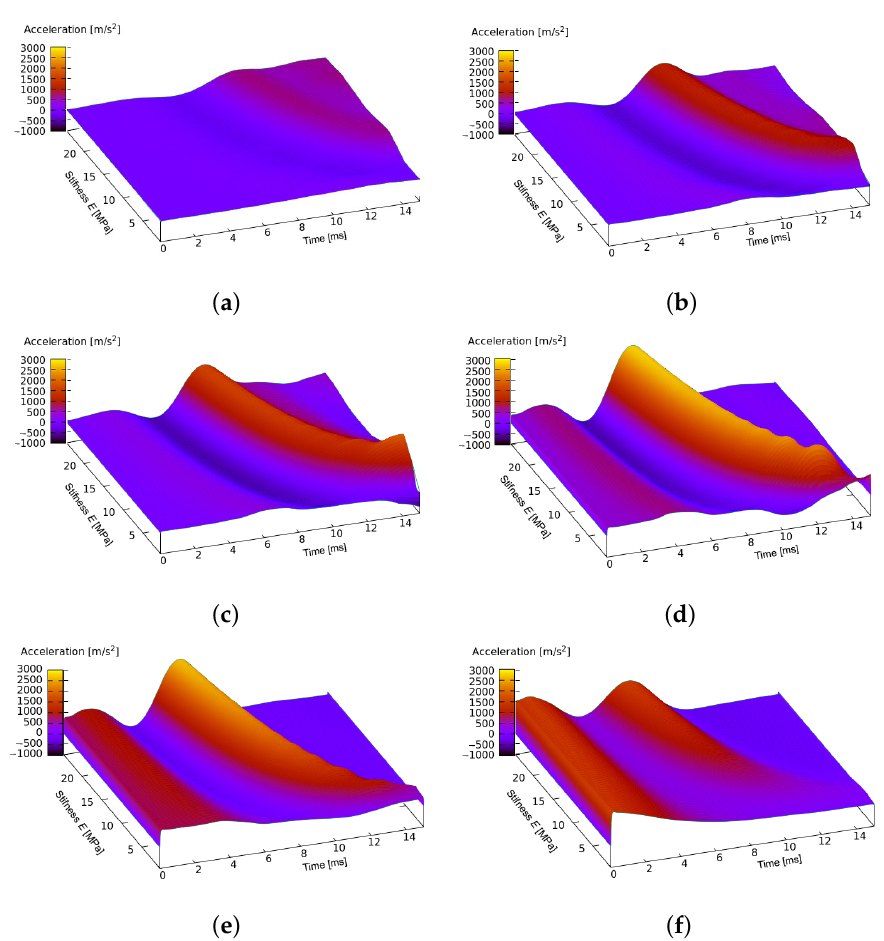
Figure 1. Simulation results for linear viscoelastic material with constant damping of ( a ) 1 Ns/m,